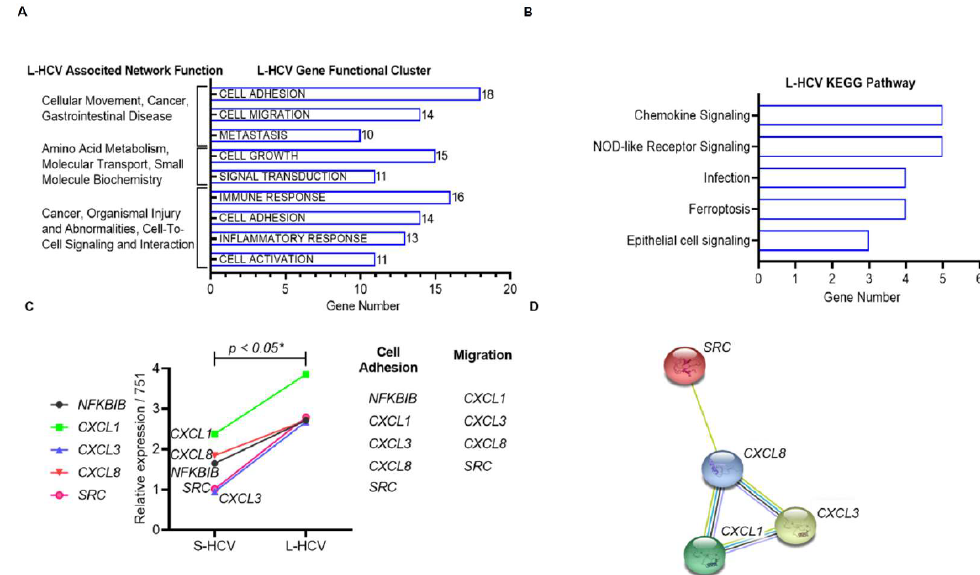
Figure 3. Long-term HCV (L-HCV)-associated network function gene analysis. ( A ) The top L-HCV-associated network functions and GenClip gene functional clusters ( p < 0.05). ( B ) ShinyGO KEGG results of the top 5 enriched pathways ( p -value cutoff (FDR) = 0.05) ranked by the number of genes from highest to lowest. ( C ) Expression of five genes ( CXCL1 , CXCL8 , NFKBIB , CXCL8 , SRC ) in the chemokine signaling pathway compared between short-term HCV (S-HCV) and long-term HCV (L-HCV), statistical significance * p < 0.05. Chemokine signaling genes grouped by functional